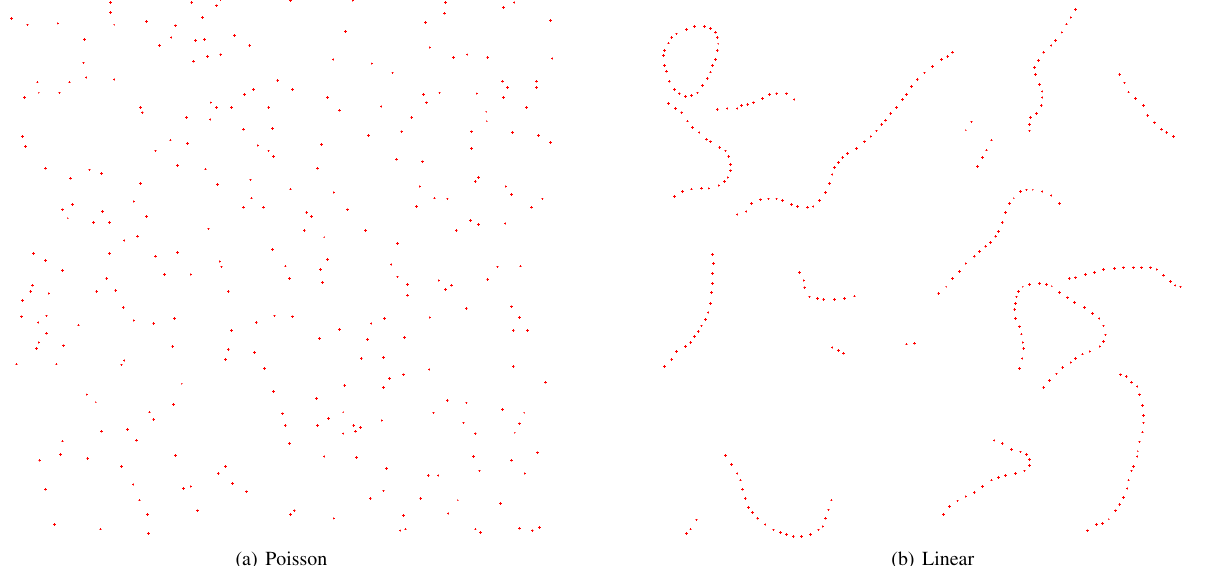
Figure 5: Two simulation results: on the left an optimal configuration of a homogenous Poisson point process is shown, in which points are distributed randomly. To the right a configuration with density defined by the proposed model is illustrated, in which points are distributed along linear curves.